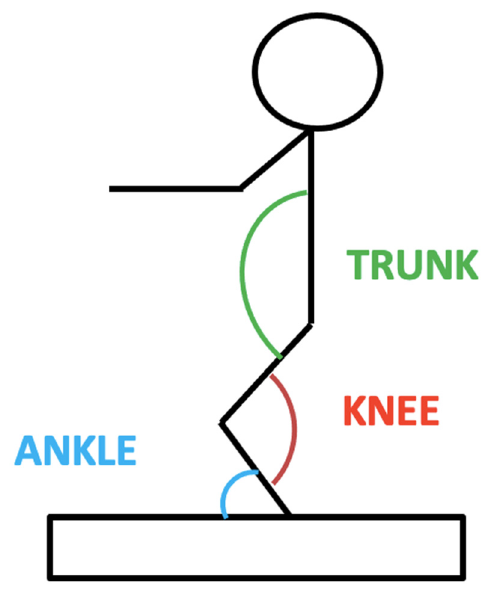
Figure 3. Angles used for controlling posture during the stimulation.